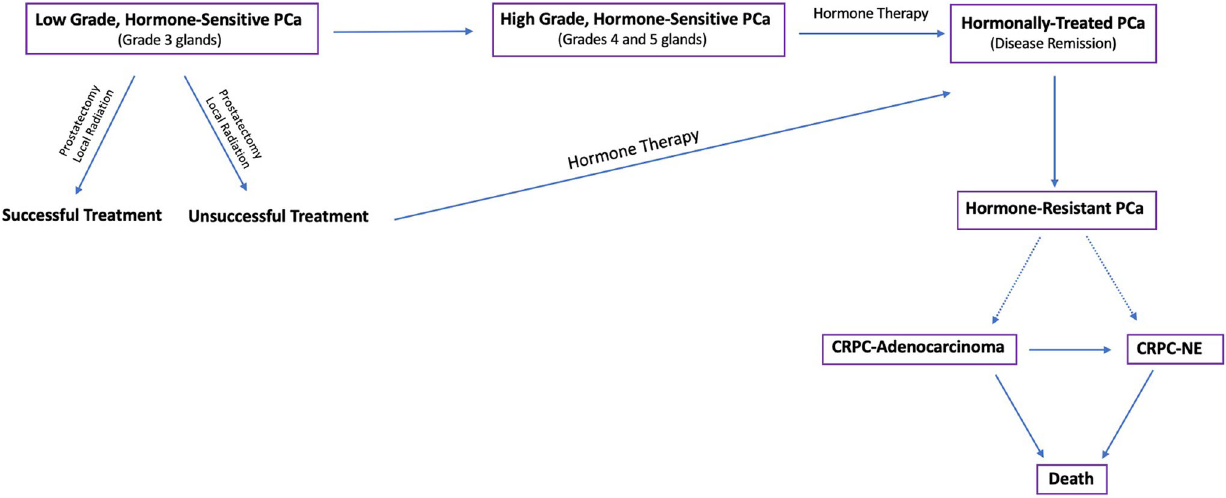
Fig. 1 The Progression of Prostate Cancer. Flow diagram depicting the progression and treatment of PCa from low grade, hormone-sensitive PCa to late stage, hormone-resistant